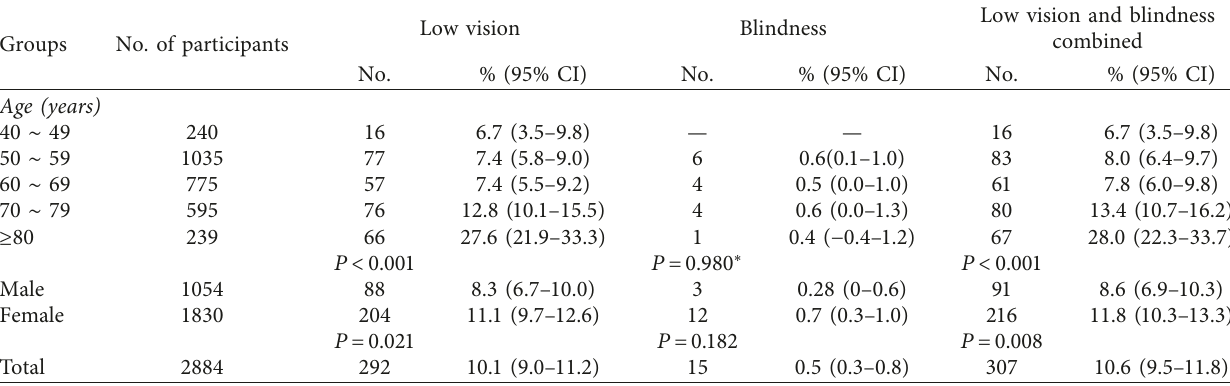
Table 3: Age- and gender-specific prevalence of bilateral visual impairment using the definition of the World Health Organization in 2010. Groups No. of